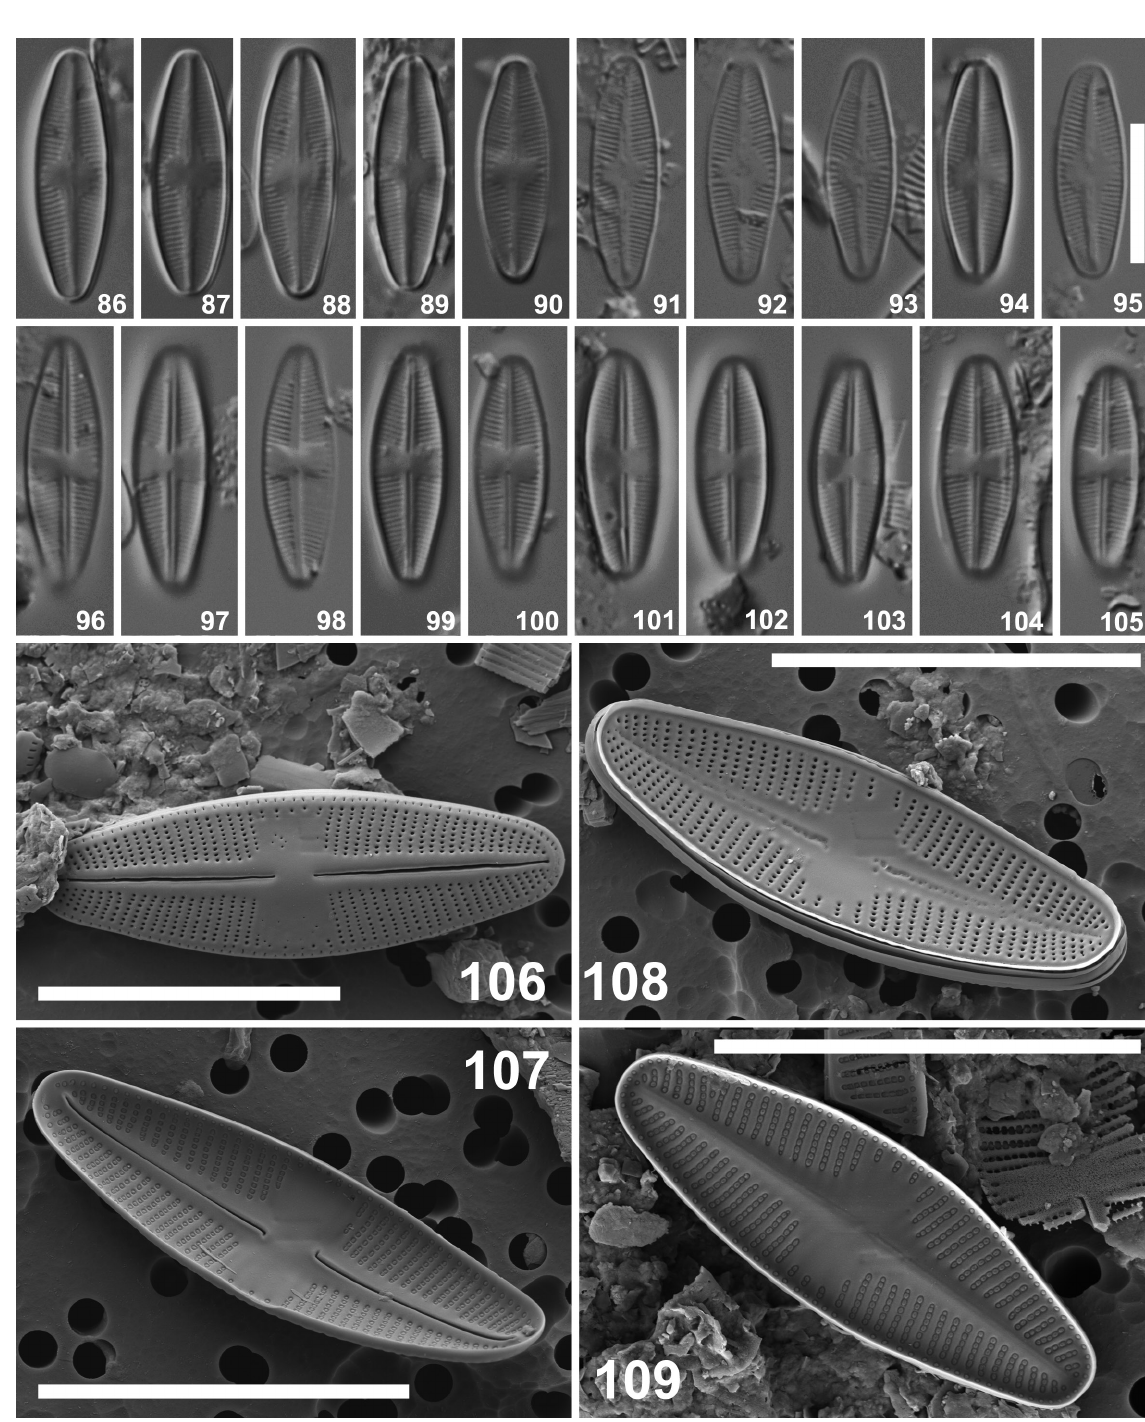
Figs 86–109. Psammothidium superpapilio Kopalová, Zidarova & Van de Vijver sp. nov. Light and scanning electron micrographs of the type population on Byers Peninsula (Livingston